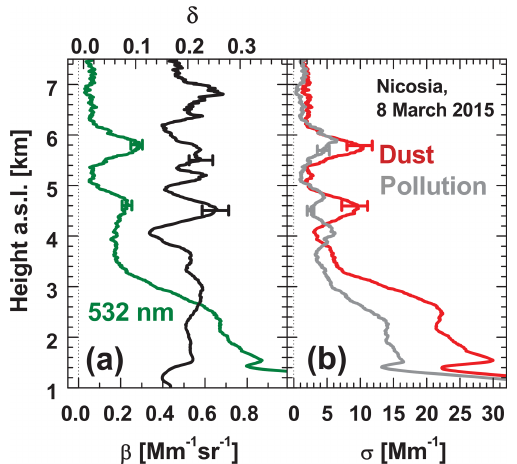
Figure 16. (a) Particle backscatter coefficient (green, 532nm) and particle linear depolarization ratio (black, 532nm); (b) correspond- ing dust and non-dust continental particle extinction coefficients. Mean lidar profiles for the time period from 22:00 to 22:20UTC are shown. The uncertainty bars show typical retrieval uncertain- ties of 10% (backscatter, depolarization ratio) and 20% (extinction